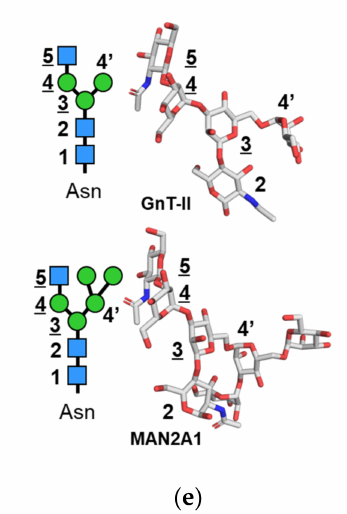
Figure 3. Crystal structure of human GnT-II. ( a ) Putative ternary complex structure of human GnT-II, UDP, and acceptor N -glycan. This model was constructed by combining the GnT-II UDP-Mn 2 + complex (PDB code: 5VCM) and GnT-II acceptor N -glycan complex (PDB code: 5VCS). The inserted loop–helix–loop (LHL181-224) is highlighted in magenta. GnT-II, UDP, acceptor glycan and Mn 2 + are shown in ribbon, stick, stick, and sphere models, respectively. ( b ) Structures of GnT-I (left panel, PDB code: 1FOA) and POMGNT-1 (right panel, PDB code: 5GGI). For comparison, the structures of these two enzymes are depicted at the same viewing angles as Figure 3a. The colors of GnT-I are same with Figure 2a. The lectin domain (97-253), N-lobe (254-502), flexible loop (503-514), linker (515-538) and C-lobe (539-647) of POMGNT-1 are colored in orange, green, magenta, cyan and blue, respectively. POMGNT-1, UDP, acceptor glycopeptide and Mn 2 + are shown in ribbon, stick, stick and sphere models, respectively. ( c ) Close up view of the UDP binding site (PDB code: 5VCM). The hydrogen and coordination bonds are shown as red dotted lines. The colors of Figure 3c-e are same with Figure 3a. ( d ) Close up view of the acceptor N -glycan binding site (PDB code: 5VCS). ( e ) Structural comparison between the acceptor N -glycan (GlcNAcMan 3 GlcNAc) bound to human GnT-II (upper panel) and substrate N -glycan (GlcNAcMan 5 GlcNAc 2 ) bound to fruit fly MAN2A1 (PDB code: 3CZN, lower panel). Schematic drawing of each N -glycan is also shown. The sugar residues of “recognition arm” (GlcNAc β 1-2Man α 1-3Man, residues 3, 4, and 5) are